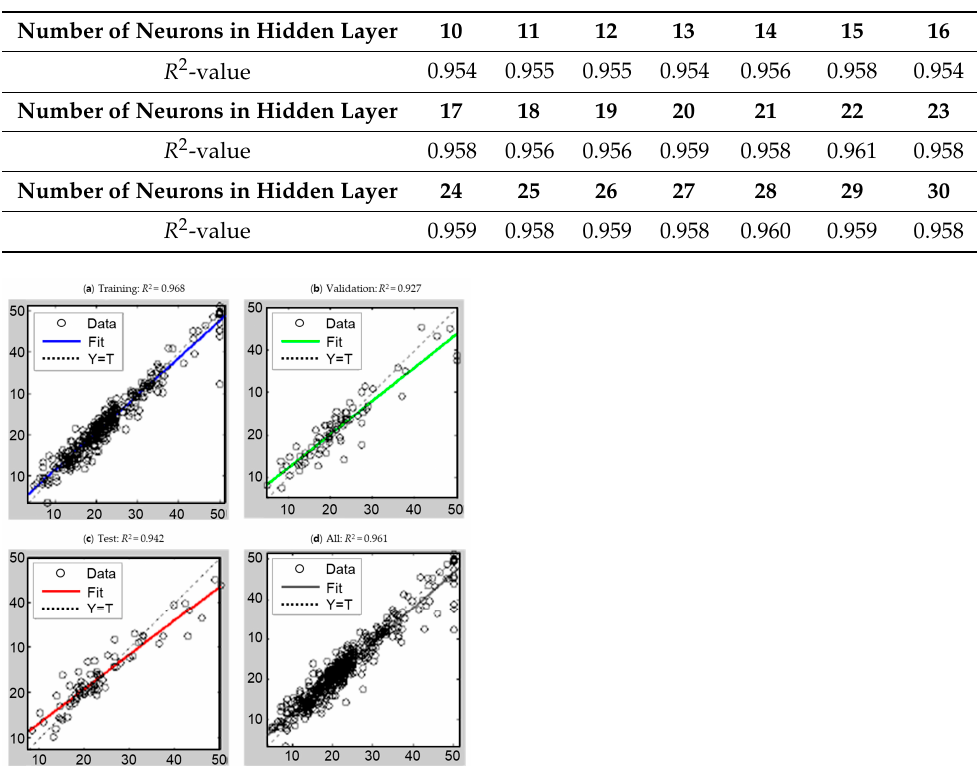
Table 7. Predicted performance results ( R 2 -values) for the change of neuron number when the number of hidden layers is fixed to five.